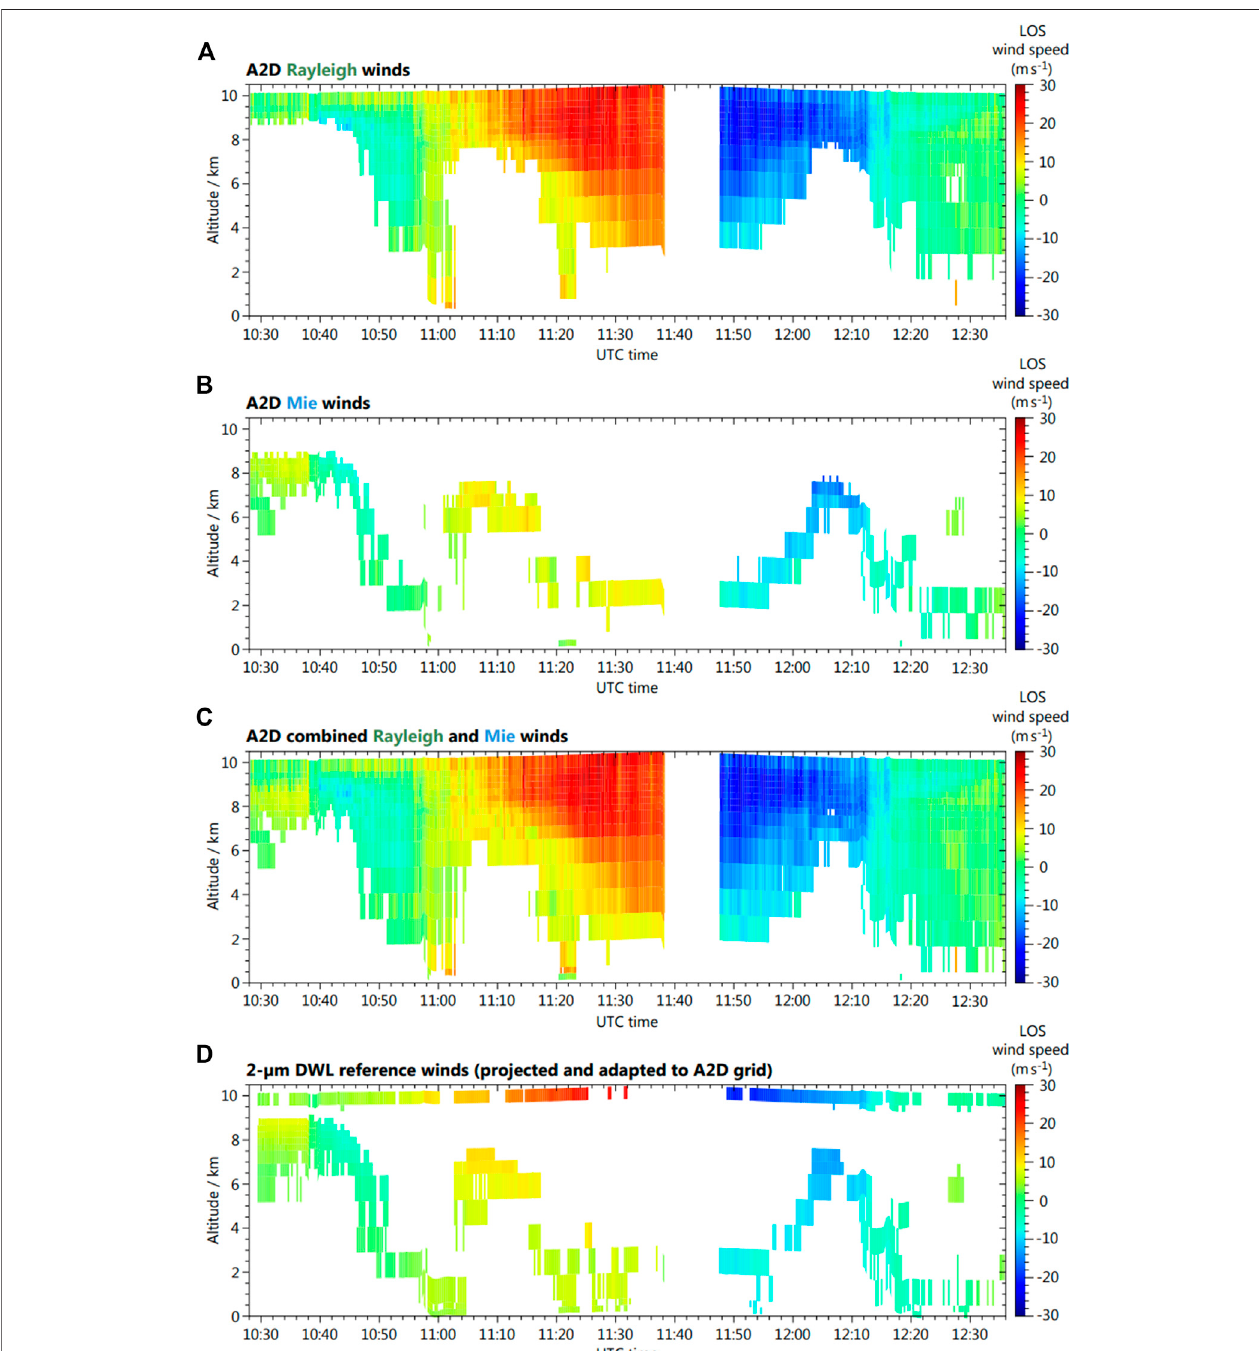
FIGURE 2 | Line-of-sight wind pro fi les (positive towards the instrument) measured using (A) the A2D Rayleigh channel and (B) the A2D Mie channel. The combination of both channels is depicted in panel (C) , while panel (D) shows the corresponding wind curtain obtained with the coherent 2- μ m reference wind lidar.